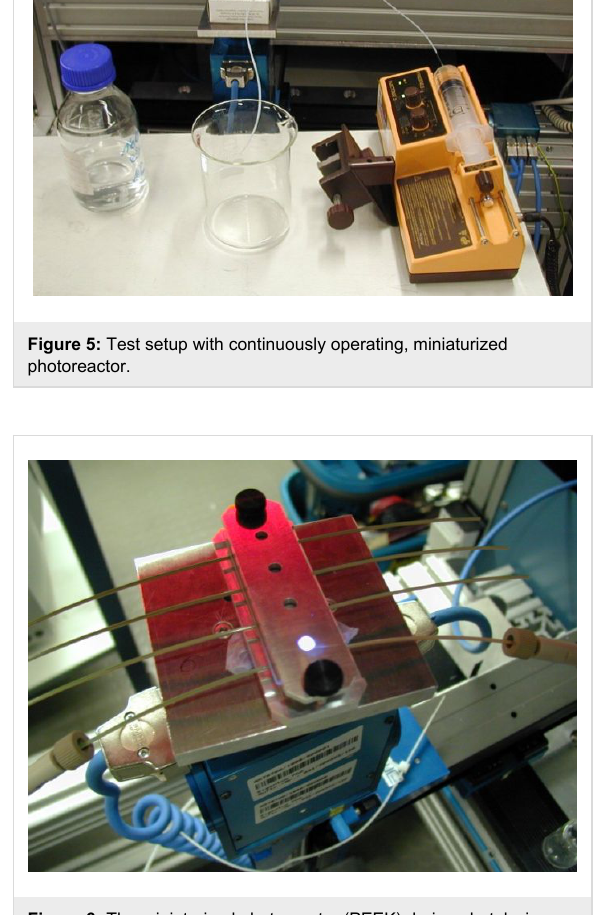
diazo derivatives 3 . The side reaction is supposedly reduced due to a lesser effect of heating owing to the small bandwidth irradi- ation and minimized exposure time through the miniaturized flow